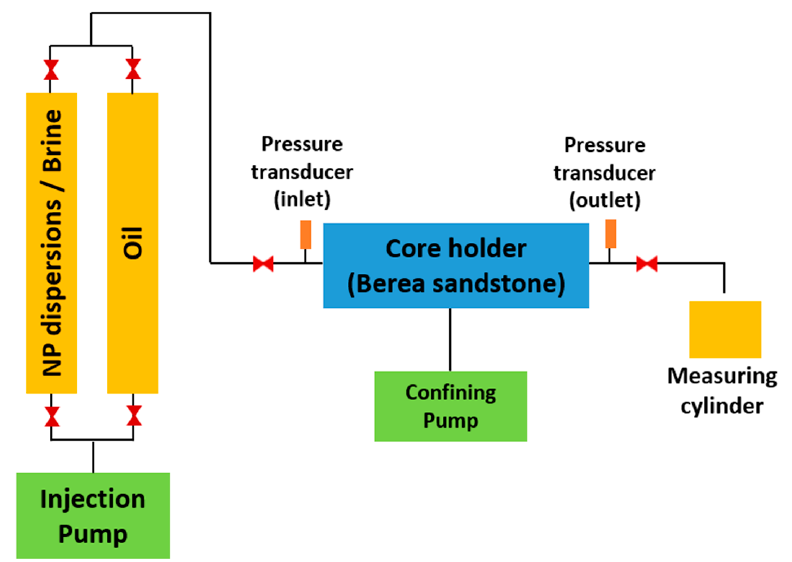
Figure 1. The diagram of the core flooding system .